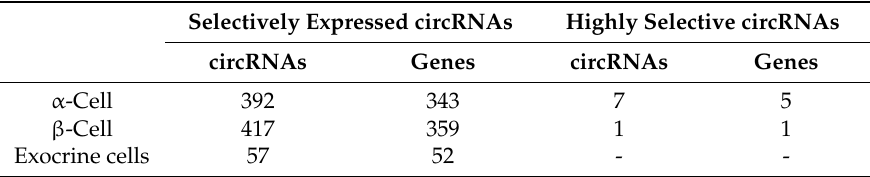
Table 4. Selectively expressed circRNAs in human islets. The number of selectively expressed circRNAs and highly selective circRNAs are listed along with the total number of host genes. Highly selective circRNAs are those that originate from the most highly and selectively expressed transcripts in each cell